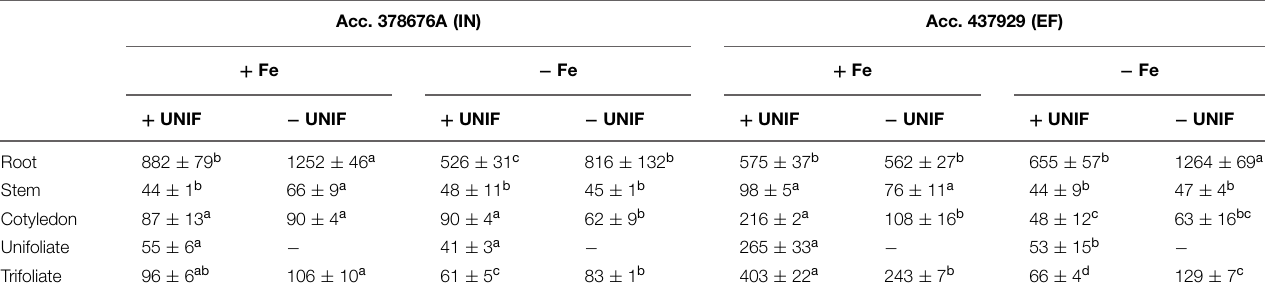
TABLE 1 | Fe concentration ( µ g/g) in root, stem, cotyledon, unifoliate leaves, and trifoliate leaves of inefficient (IN) and efficient (EF) G. max accessions grown with ( + UNIF) and without ( − UNIF) unifoliate leaves, under Fe-deficient ( − Fe) and Fe-sufficient ( + Fe) hydroponic conditions (Experiment